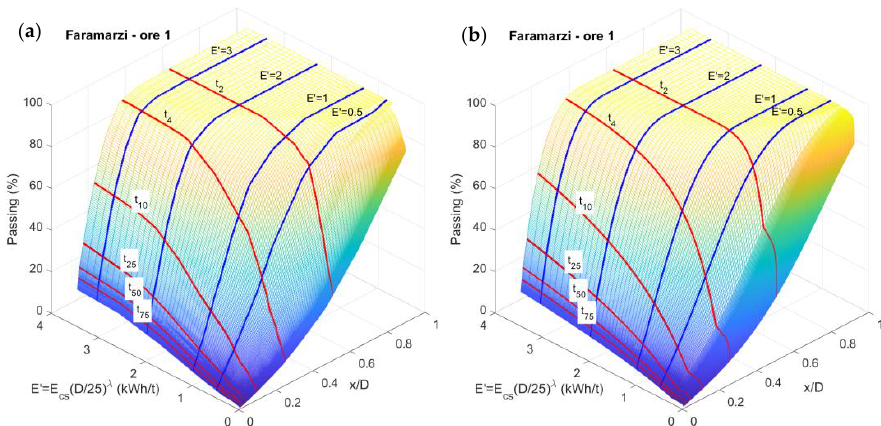
Figure A11. 3D breakage plots for Faramarzi’s [ 27] ore 1. ( a ) from data. ( b ) from double fan model (direct fit, constant λ , E min ≥ 0 ).